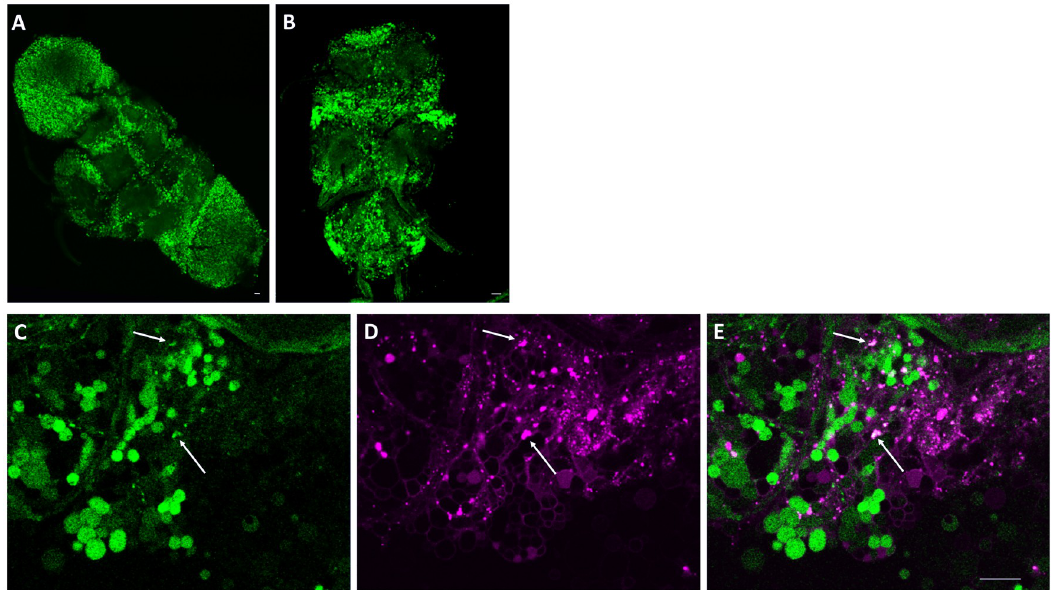
Fig 4. sei promoter drives expression in neurons and glia. A-B ) Representative confocal z-stack images of an adult brain ( A ) and ventral nerve cord ( B ) from sei-LexA > LexAOp-GFPnls (green) flies. C-E ) Overlap of sei-LexA > LexAOp-GFPnls (green) and glial marker RepoGAL4 > UAS-RedStinger (magenta). Arrows point to examples of co-labeled cells. Scalebars are 20 μ